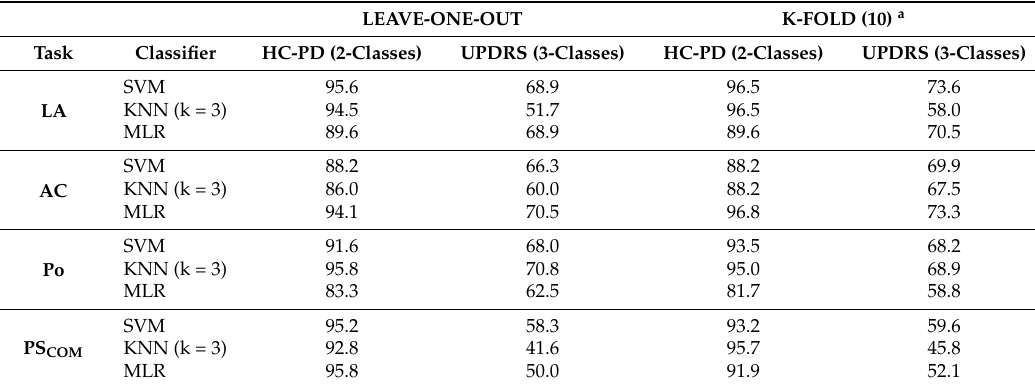
Table 11. Classification accuracies for the supervised